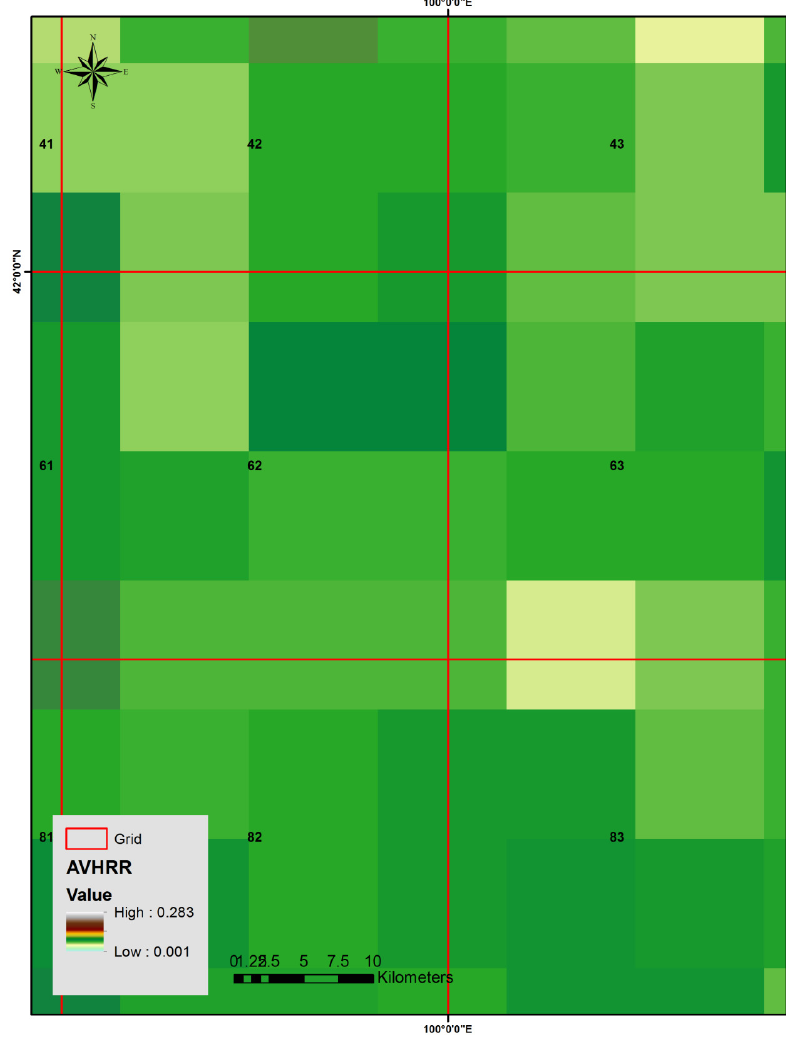
Figure 2. The overlap between APHRODITE (large red cells) and AVHRR NDVI data (small cells), resulting in 16 small cells in each large